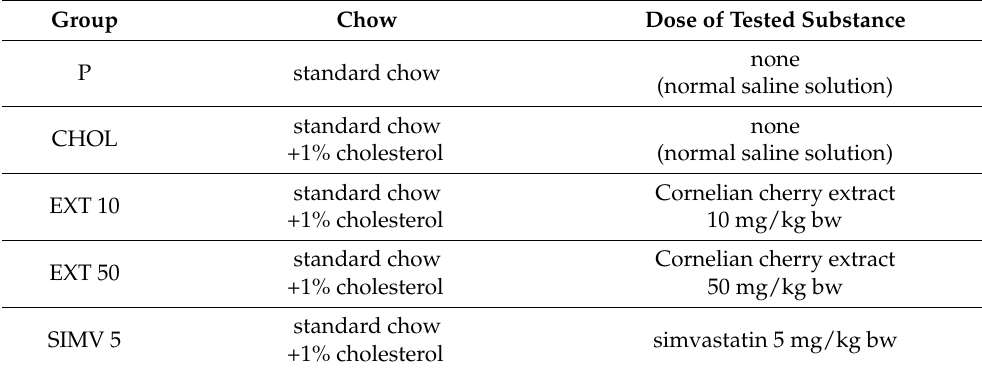
none (normal saline solution) none (normal saline solution) Cornelian cherry extract 10 mg/kg bw Cornelian cherry extract 50 mg/kg bw simvastatin 5 mg/kg